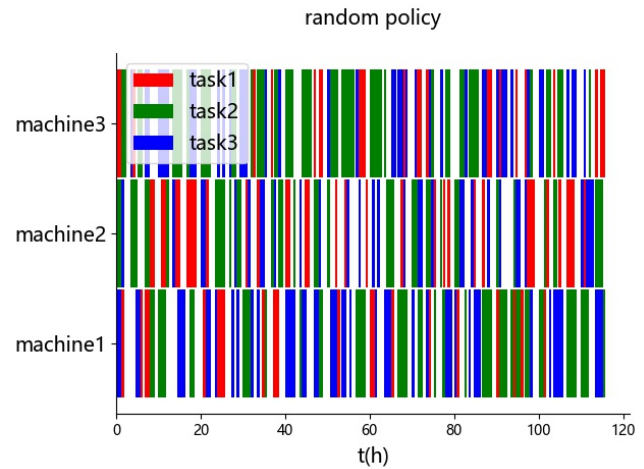
Figure 8. Gantt chart of random strategy scheduling method.